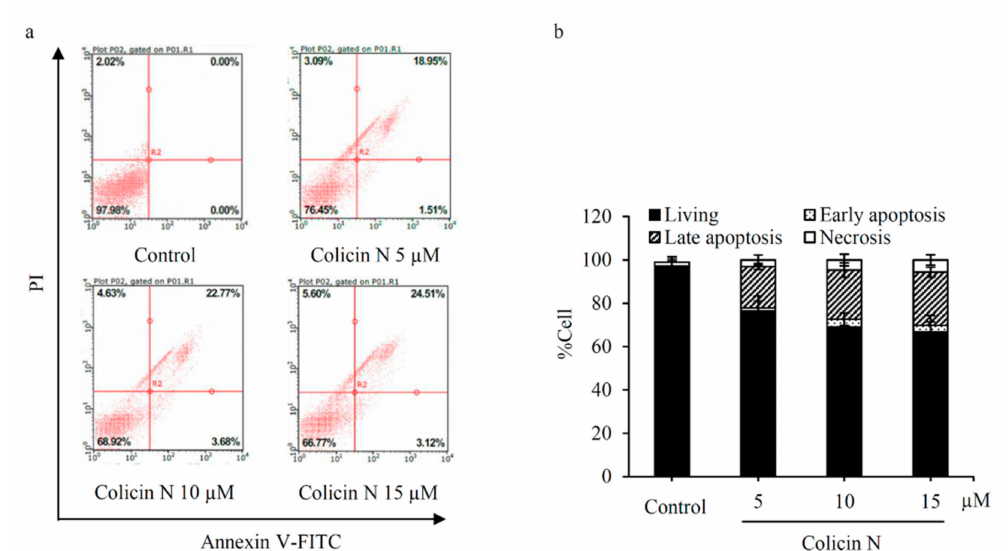
Figure 3. Flow cytometry analysis of mode of cell death in colicin N-treated lung cancer cells ( a ) Annexin V-FITC / propidium iodide (PI) histograms were obtained from analysis of lung cancer H460 cells incubated with 5–15 µ M of colicin N for 24 h. Treatment with colicin N